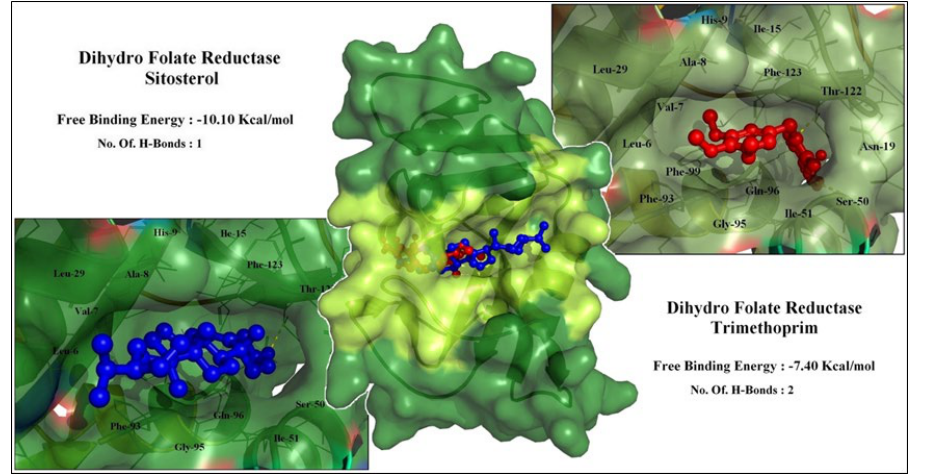
Fig. 6. Interaction between DHFR enzyme and sistosterol in comparison with